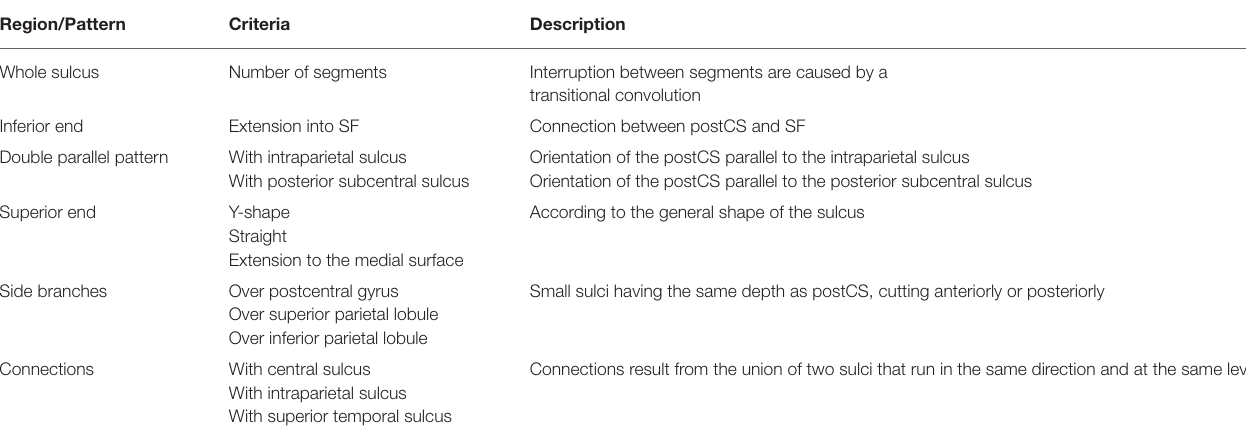
TABLE 3 | Description of the 13 criteria defining the pattern of the postCS.